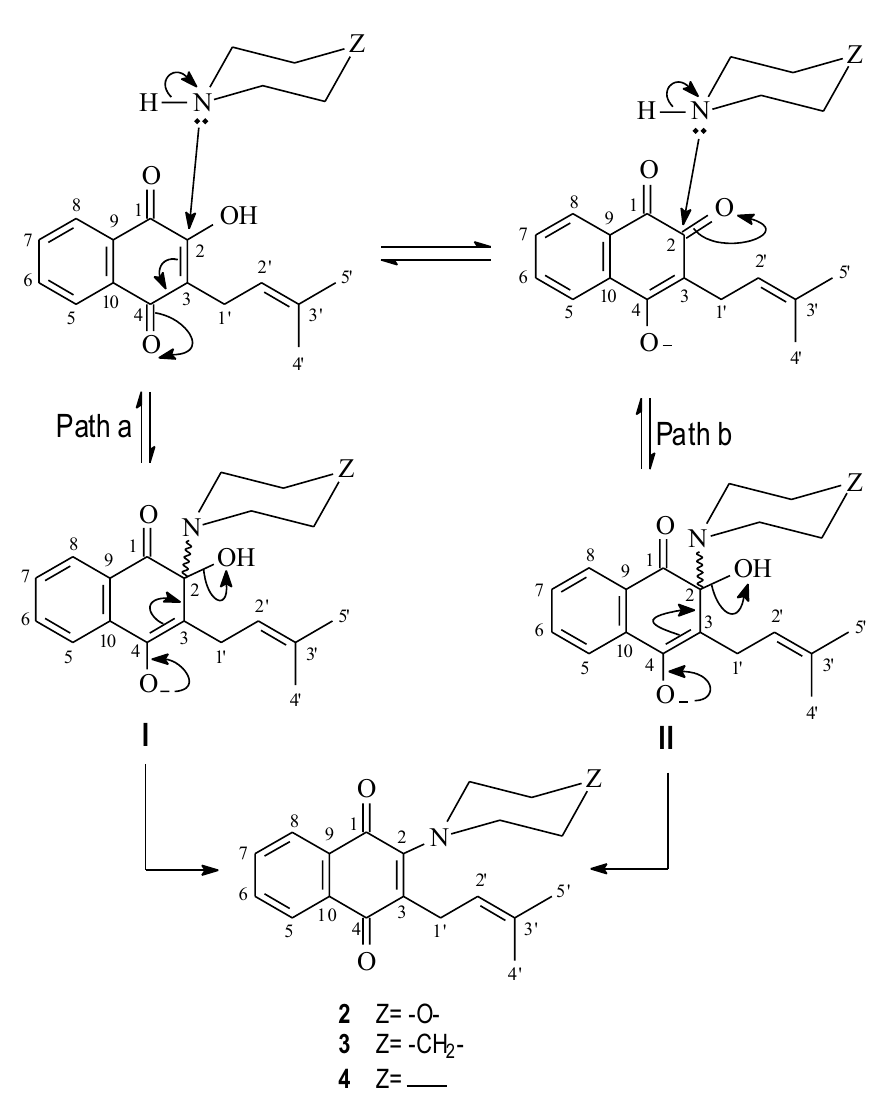
Fig. 2 – Proposed mechanism for the reaction of the amines morphiline, piperidine and pyrrolidine with lapachol ( 1 ) leading to the formation of the corresponding enamine derivatives 2-4